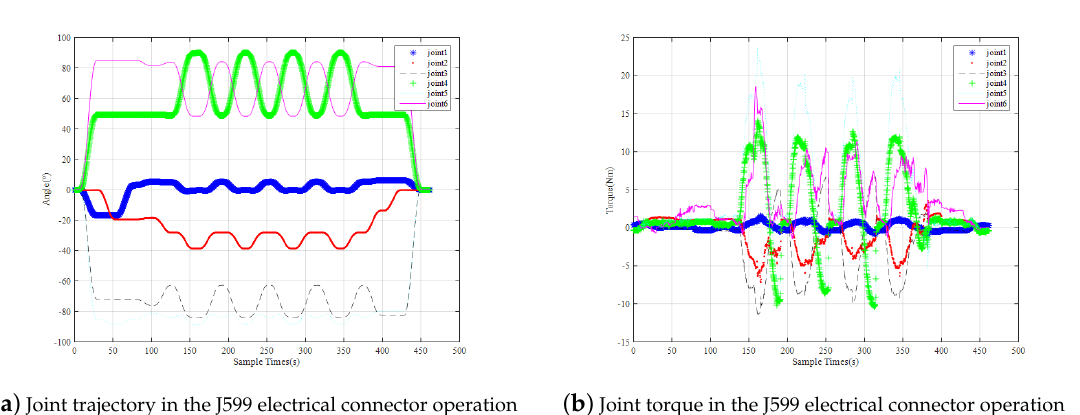
Figure 12. Joint Trajectory and Joint Torque of Robot Arm in the Experiment of Turning the J599 Electric Connector.